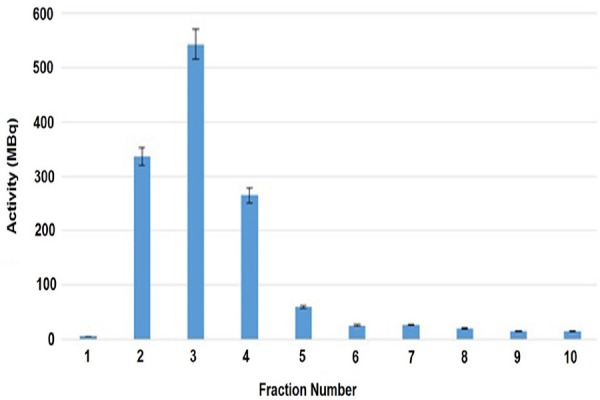
Elution diagram of the 68Ge/68Ga generator used in this study.